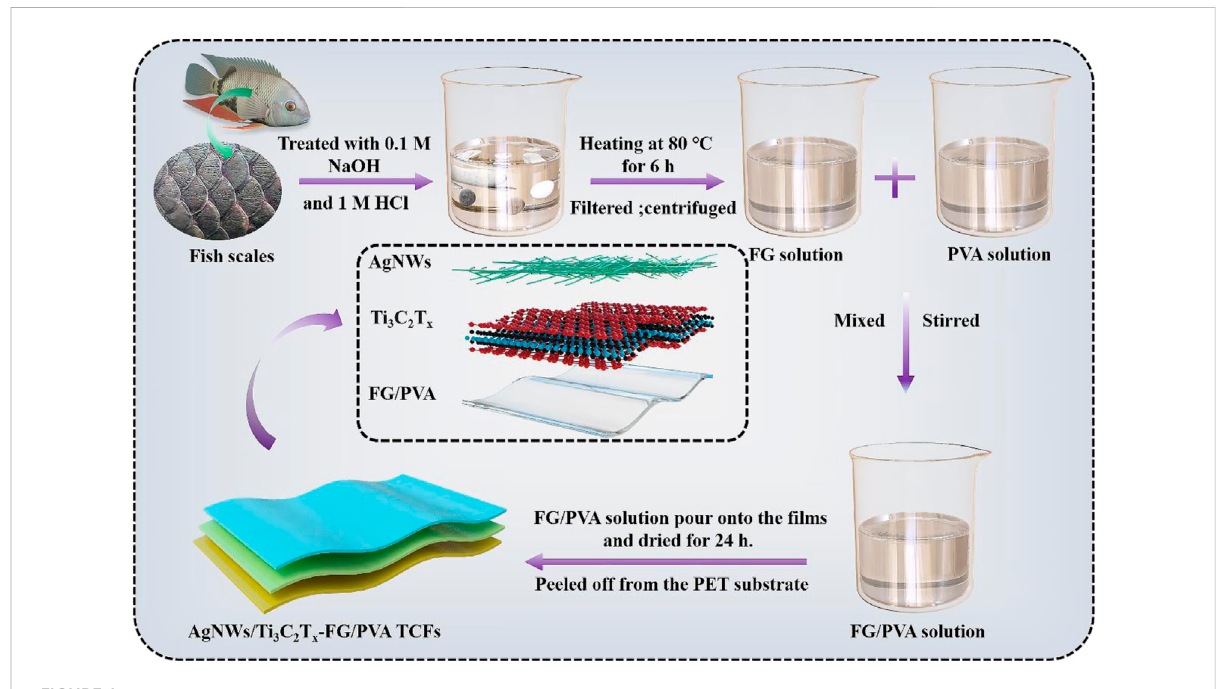
FIGURE 1 The preparation process of the AgNWs/Ti 3 C 2 T x -FG/PVA fi